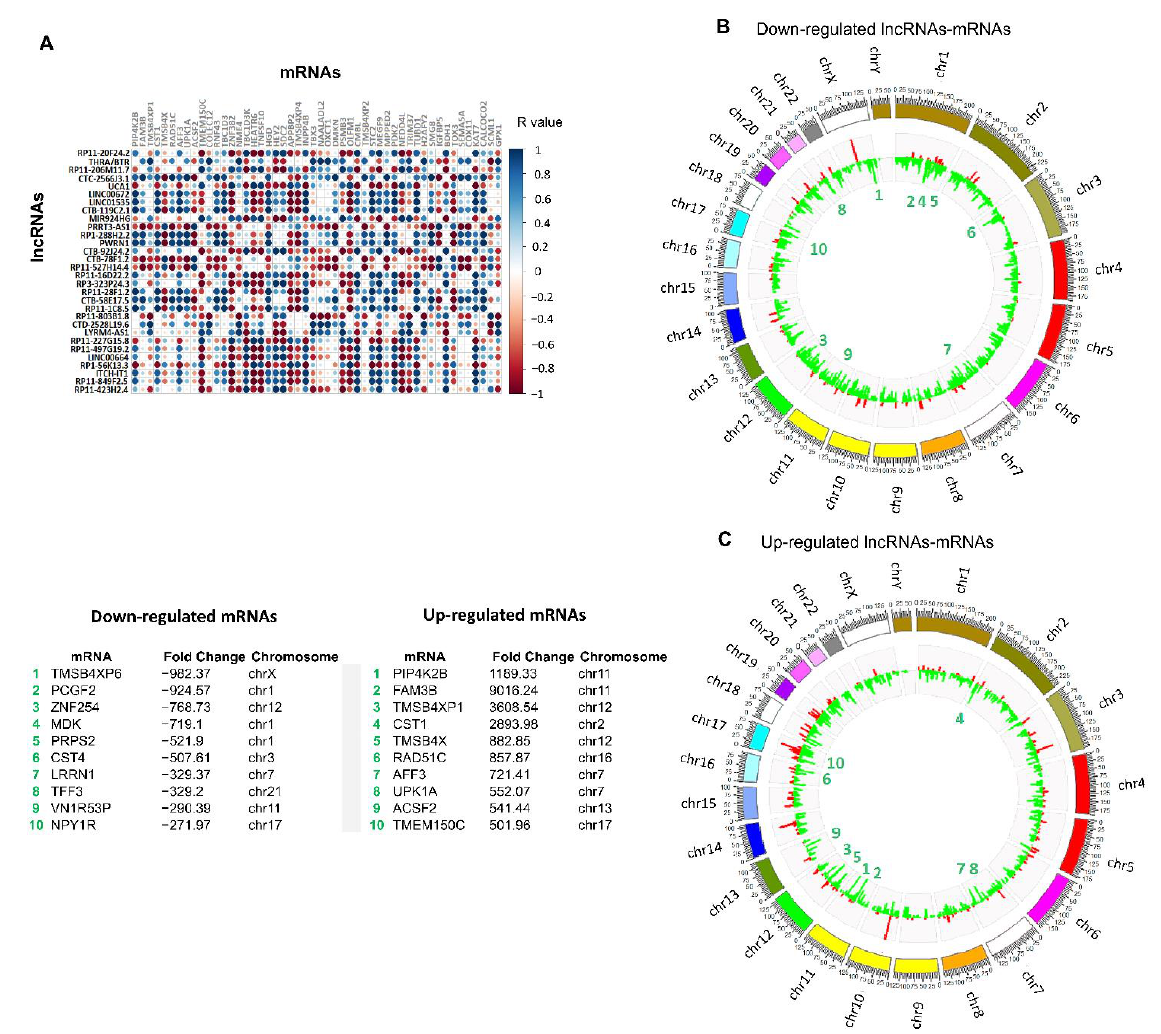
Figure 3. Correlated mRNAs/lncRNAs pairs. ( A ) Representative plot of the Pearson’s correlations found in the first 30 lncRNAs with the highest values of fold change. Blue circles represent the over-expressed lncRNAs/mRNAs pairs with a degree of positive linear association (≥0.9). ( B ) Circos plot of chromosomal distribution of down-regulated lncRNAs/mRNAs correlated pairs, lncRNAs are shown in red and mRNAs in green. Height indicates degree of differential expression. ( C ) Circos plot of chromosomal distribution of up-regulated lncRNAs/mRNAs correlated pairs; lncRNAs are shown in red and mRNAs in green. Height indicates degree of differential expression. Bottom list indicates the chromosomal location of the top-ten deregulated lncRNAs in 3D cultures.